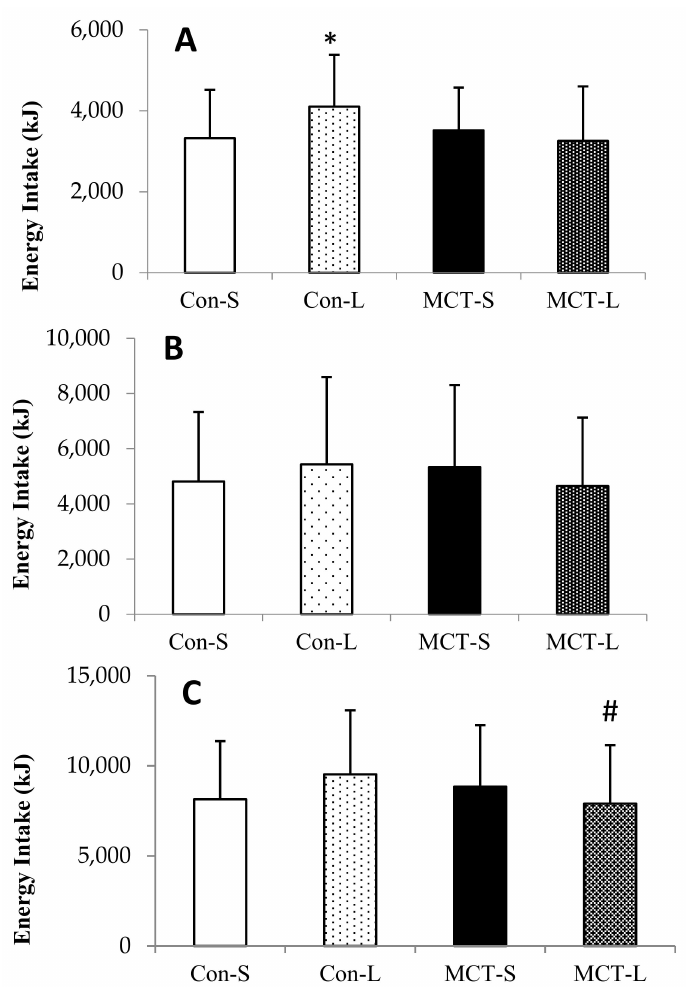
Figure 1. Mean and individual energy intake (kJ) at the ad libitum meal ( A ), free-living environment ( B ) and total over the whole day ( C ). Data are expressed as means and vertical bars indicate standard deviation. * Denotes a significant di ff erence compared to all other trials, # denotes a significant di ff erence compared to control oil in liquid form (Con-L). Significance was accepted at the p < 0.05